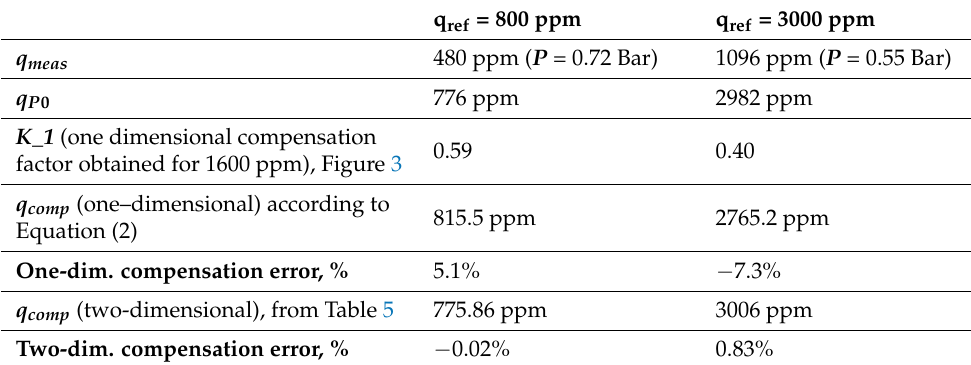
Table 6. Compensated concentrations compared to true values for different concentrations (cid:54) = pressure calibration